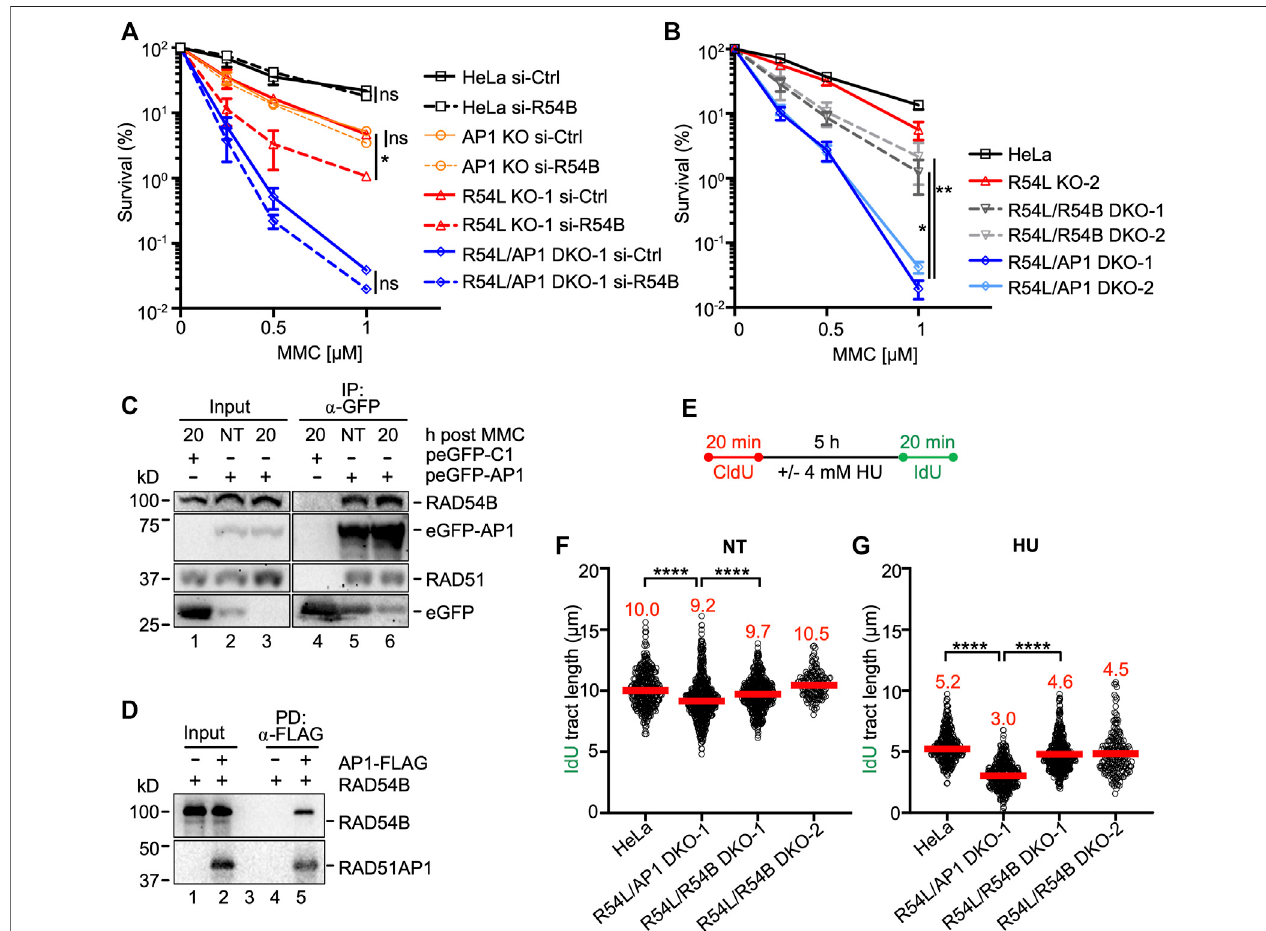
FIGURE 4 | Concomitant loss of RAD54L and RAD54B exacerbates MMC cytotoxicity and replication stress less severeley than concomitant loss of RAD54L and RAD51AP1 . (A) Results from clonogenic cell survival assays after MMC of cells transfected with negative control (si-Ctrl) or RAD54B siRNA (si-R54B): HeLa, AP1 KO, R54L KO-1, R54L/AP1 DKO-1 cells. Data points are the means from two independent experiments ±SD. *, p < 0.05; ns, non-signi fi cant; two-way ANOVA followed by Tukey ’ s multiple comparisons test. (B) Results from clonogenic cell survival assays after MMC treatment of HeLa, R54L KO-2, R54L/54B DKO-1 and KO-2, and R54L/AP1 DKO-1 and DKO-2 cells. Data points are the means from two independent experiments ±SD. *, p < 0.05; **, p < 0.01; two-way ANOVA followed by Tukey ’ s multiple comparisons test. (C) Western blots to show that endogenous RAD54B co-precipitates in anti-eGFP protein complexes of R54L/AP1 DKO cells ectopically expressingeGFP-RAD51AP1(here:peGFP-AP1)intheabsenceofMMC(NT;lane5)and20 haftera2-hincubationin0.5 μ MMMC(lane6).RAD51:positivecontrolfor interaction,aspreviouslyshownindifferentcelltypes(Kovalenkoetal.,1997;Wieseetal.,2007).Lane4:NeitherRAD54BnorRAD51co-precipitateinanti-eGFPprotein complexes generated from R54L/AP1 DKO cells transfected with control plasmid (peGFP-C1). (D) Western blots to show direct interaction between puri fi ed FLAG- tagged RAD51AP1 protein (here: AP1-FLAG) and puri fi ed RAD54B precipitated by anti-FLAG M2 af fi nity resin (lane 5). (E) Schematic of the protocol for the DNA fi ber assay. (F) Median IdU tract length under unperturbed conditions (NT) in HeLa, R54L/AP1 KO-1, and R54L/R54B DKO-1 and DKO-2 cells. Data points are from 150 to 200 fi bersofthreeexperimentsforHeLa,R54L/AP1DKO-1andR54L/R54BDKO-1cellsandfromoneexperimentforR54L/R54BDKO-2cells,withmediansinred. (G) Median IdU tract length after HU in HeLa, R54L/AP1 KO-1, and R54L/R54B DKO-1 and DKO-2 cells. Data points are from 150 to 200 fi bers of three experiments for HeLa, R54L/AP1 DKO-1 and R54L/R54B DKO-1 cells and from one experiment for R54L/R54B DKO-2 cells, with medians in red. ****, p < 0.0001; Kruskal-Wallis test followed by Dunn ’ s multiple comparisons